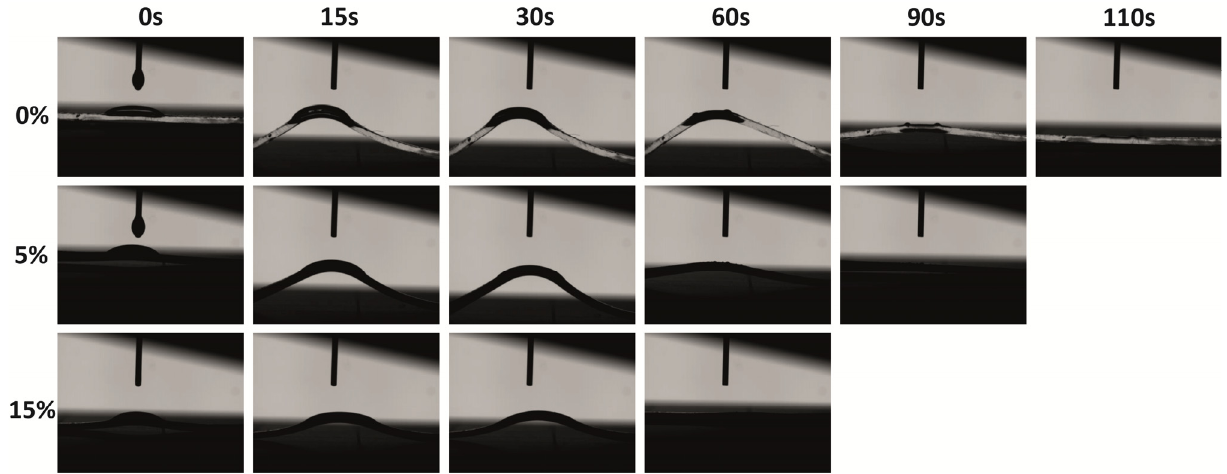
Figure 8. Toluene’s contact angle images for PDMS and TiO 2 /MCM/PDMS composites (at various TiO 2 /MCM wt%) as a function of time.